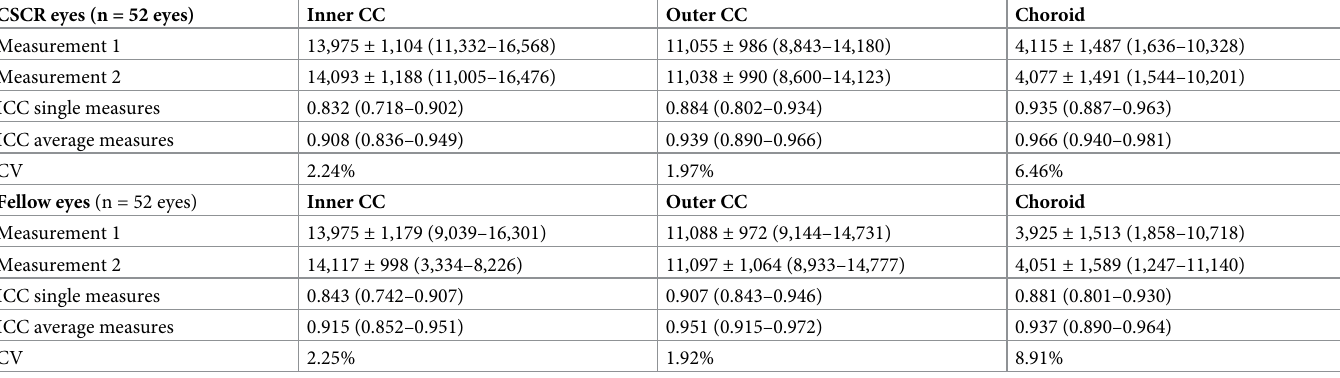
Table 2. Absolute values and repeatability of flow signal voids (FSV) number of contours in the different groups and slabs studied by swept-source optical coher- ence tomography angiography.